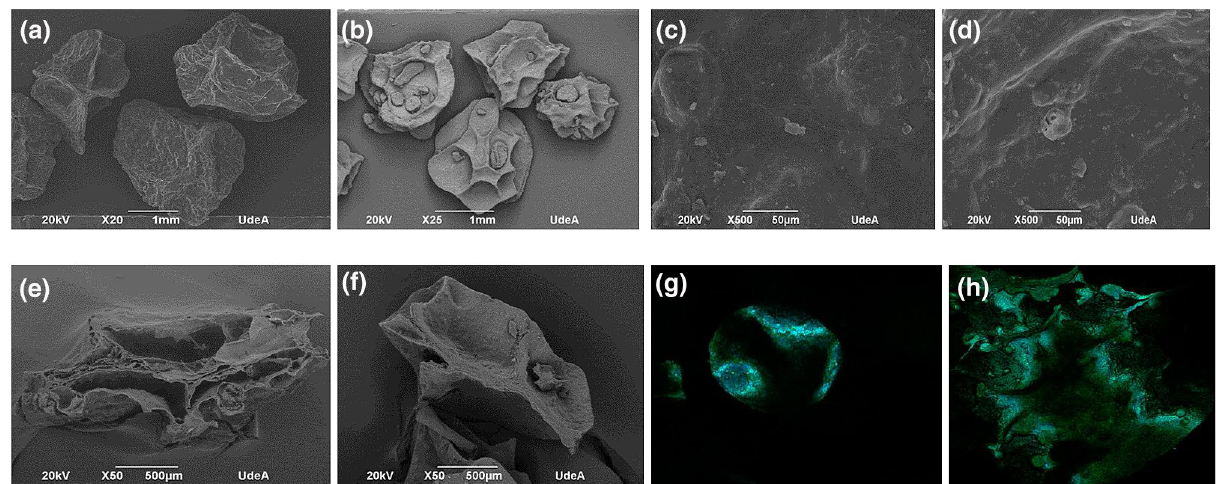
Figure 3. SEM micrographs for beads obtained by EG and IG. ( a ) EG beads at 20 ×; ( b ) IG beads at 25 ×; ( c ) surface obtained by EG at 500 ×; ( d ) surface obtained by IG at 500 ×; ( e ) Cross-sectional view obtained by EG at 50 ×; ( f ) cross-sectional view obtained by IG at 50 ×, ( g ) confocal image obtained by IG; ( h ) confocal image obtained by EG.